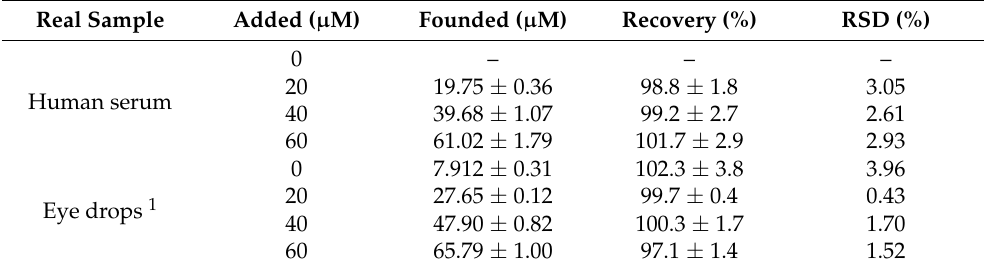
Table 2. CAP quantification in real samples using C-BN/GCE sensor (n = 3). Real